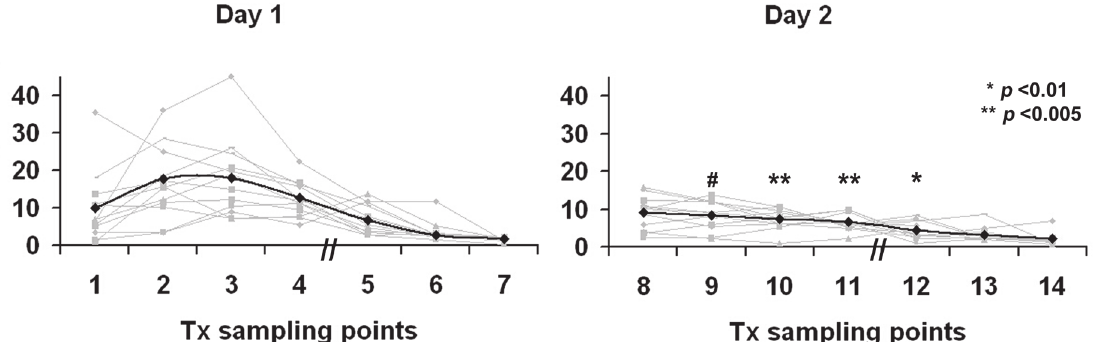
Figure 1. Effects of total sleep deprivation on saliva cortisol levels. Individual saliva cortisol curves (grey line) and cortisol mean value (nmol/L) per Tx sampling point (solid line). Day 1 shows baseline cortisol sampling at T1-T7, day 2 shows effects of one night of total sleep deprivation on cortisol levels at T8-T14. T1, 2 and 3 comprise the cortisol awakening response (CAR). T8, 9 and 10 are sampled at identical time points the following day. T5 and T12 are sampled at 14.00hr, T6 and T13 at 17.00hr and T7 and T14 at 23.00hr. p values show effects of TSD, # p =